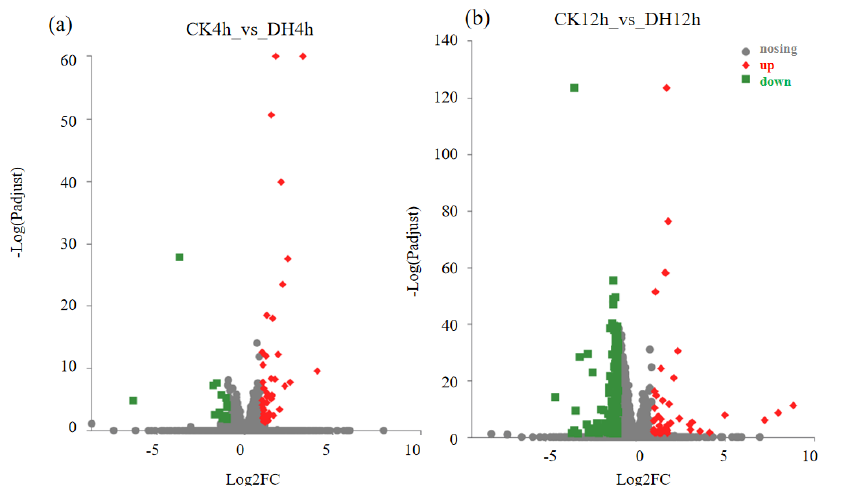
Figure 2. Volcano plot of DEGs identified in ovaries at 4 h ( a ) and 12 h ( b ) after DH injection. X -axis: log2−fold change (treatment/control). Y -axis: log10(FDR). Red data points indicated up-regulated unigenes and green data points indicated down-regulated unigenes.